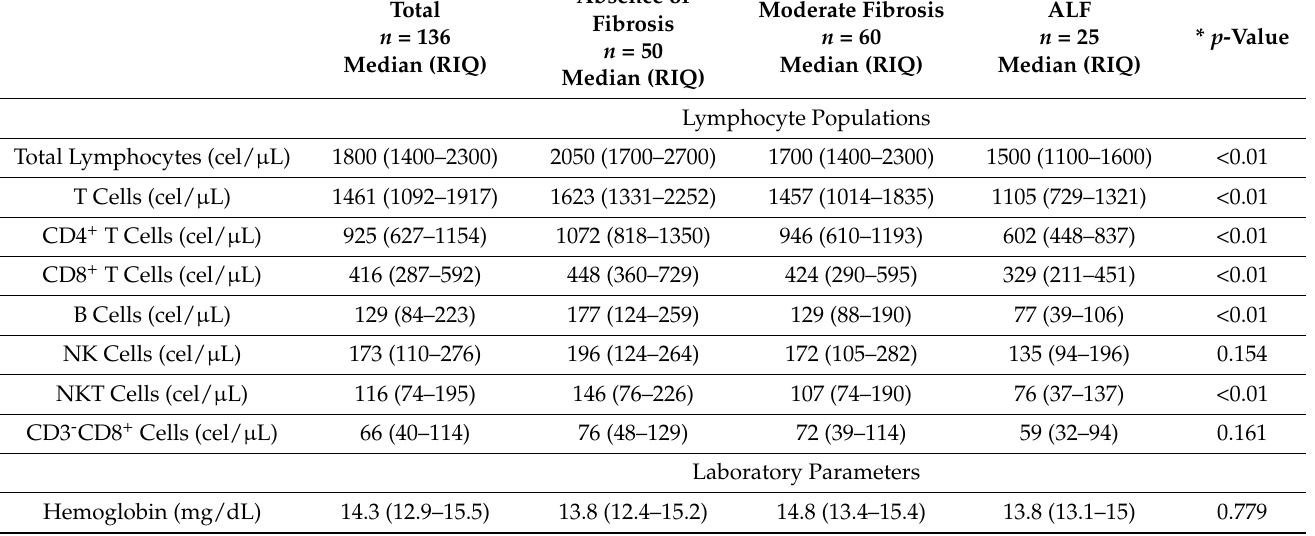
Table 2. Lymphocyte subpopulations and laboratory parameters in 136 patients according to